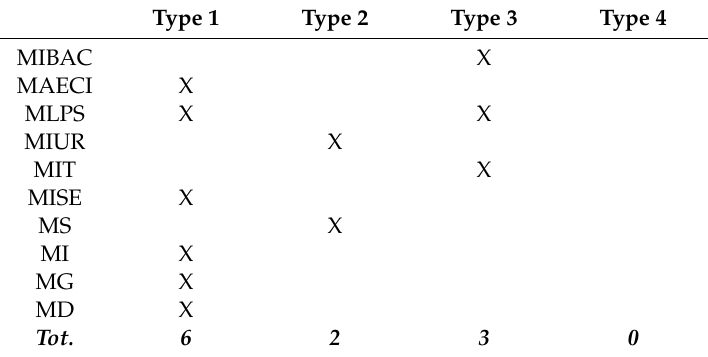
Table 5. Prevailing type of integration for each